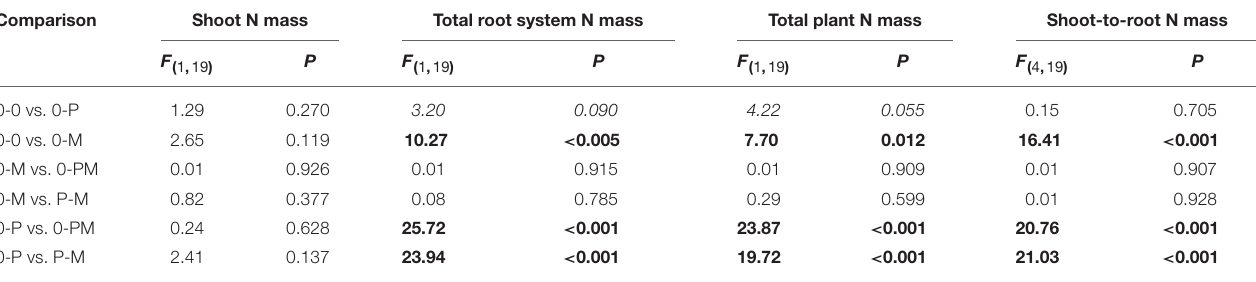
TABLE 2 | F - and P -values of GLM contrasts showing treatment effects on total shoot N mass, total root N mass, total plant N mass, and shoot-to-root N mass ratio of Triticum aestivum . Comparison